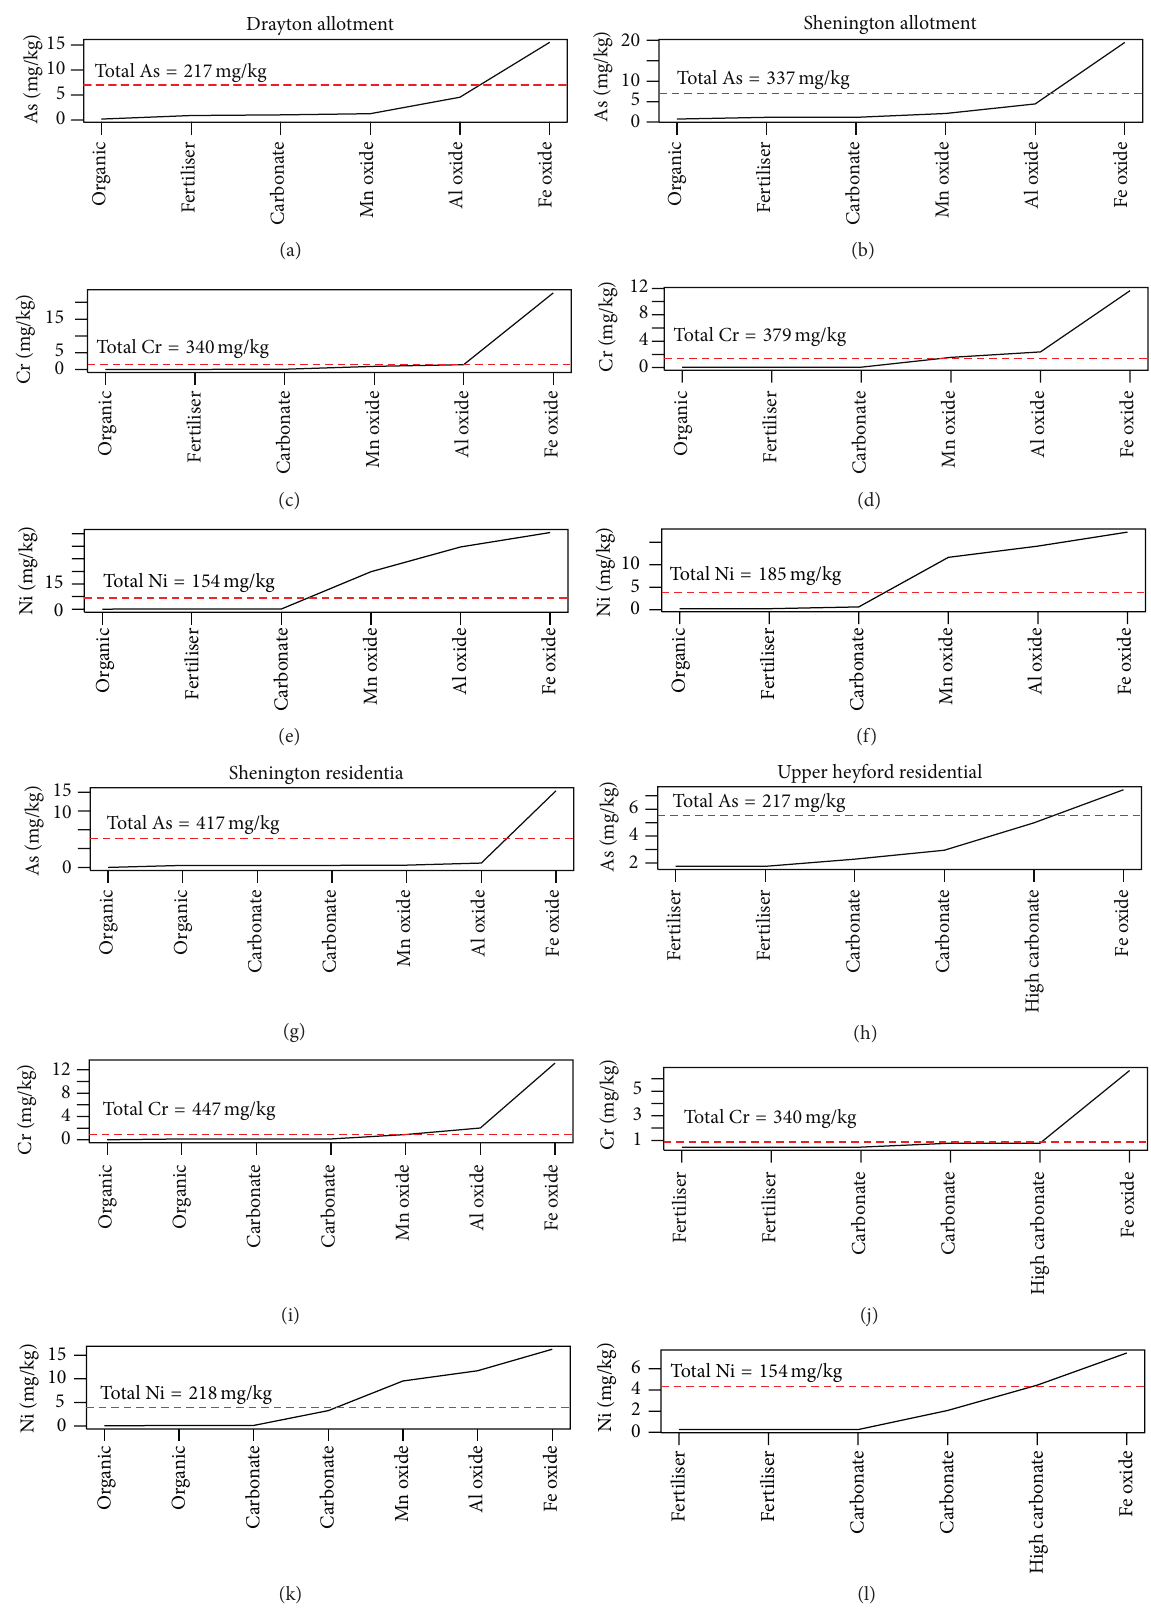
Figure 7: Comparisons of the cumulative mass of As, Cr, and Ni extracted in the CISED identified physicochemical components and its relationship to the bioaccessible fractions. Solid line represents the cumulative mass extracted; the dashed line represents the bioaccessible fraction. Total concentrations of elements are noted on the